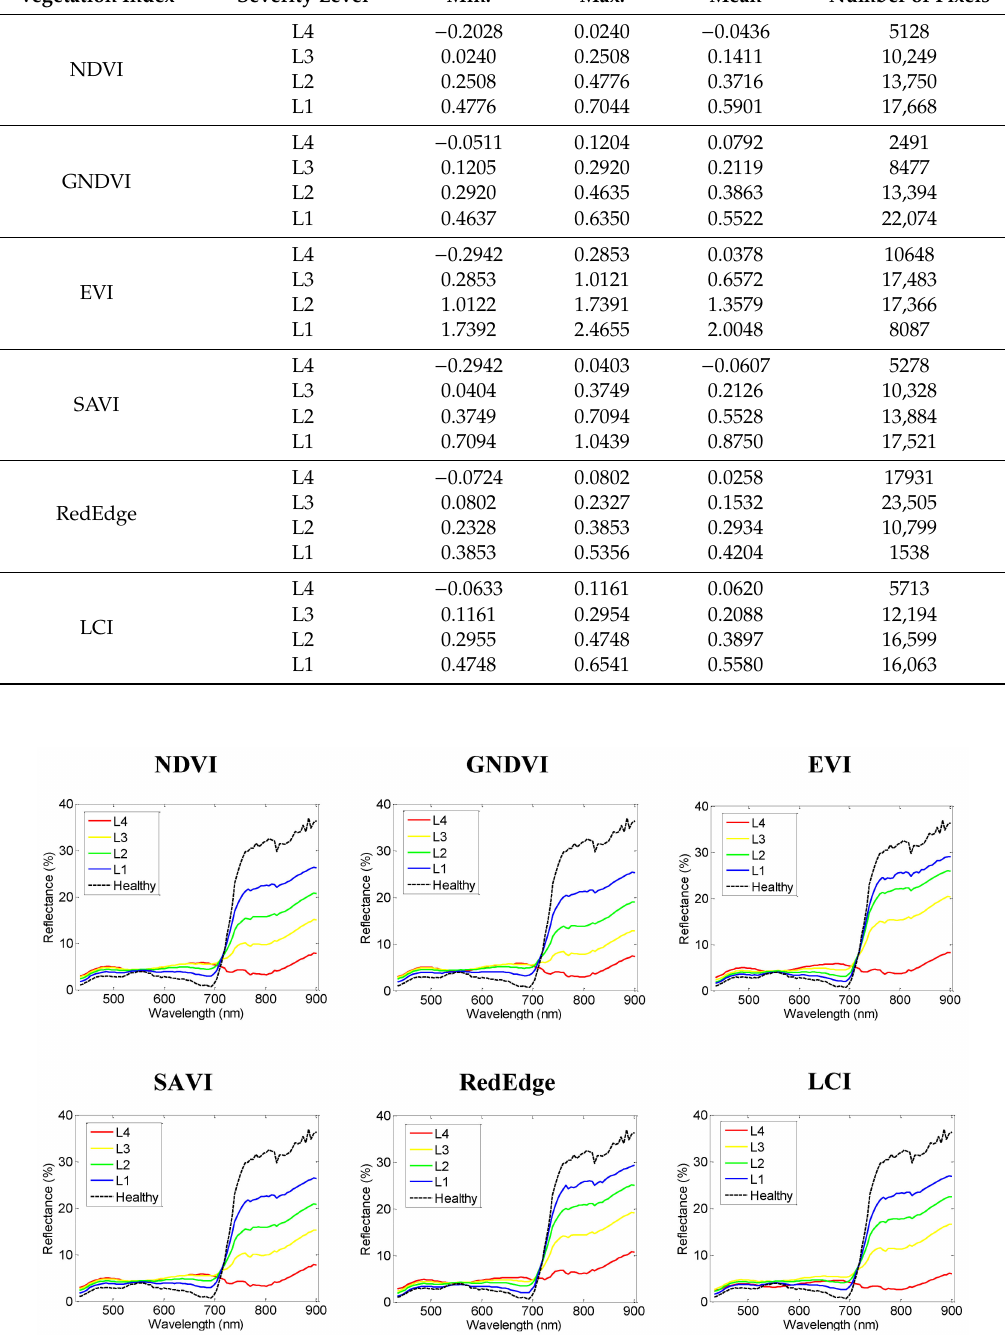
Figure 8. Average spectra of di ff erent severity levels of cotton root rot in Field